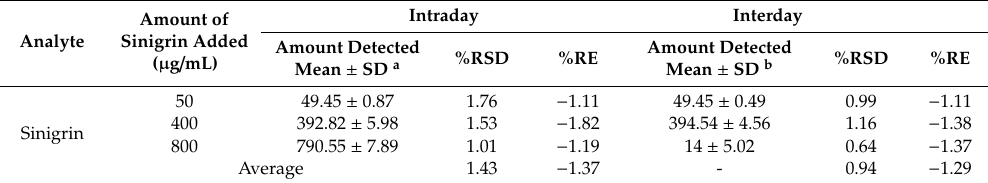
Table 2. Results of accuracy and precision data of sinigrin.